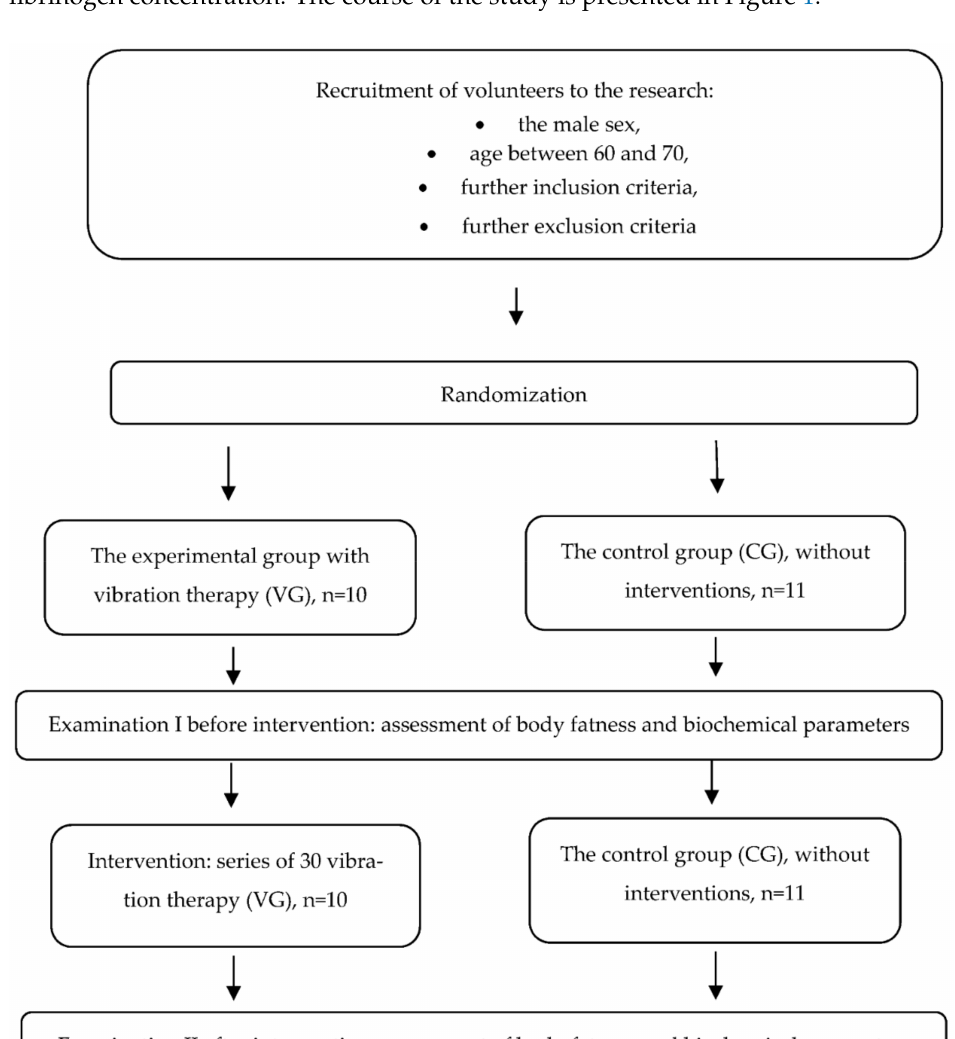
Figure 1. The course of the